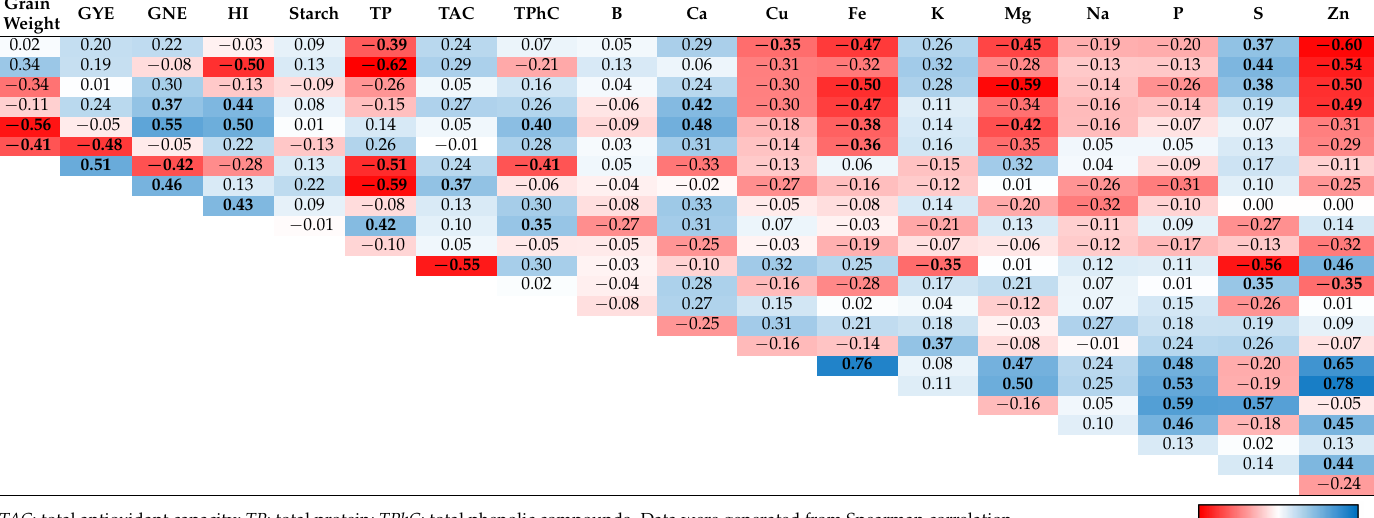
Table 6. Correlation coefficient matrix for the wheat production, grain yield, non-mineral, and mineral nutrient components among of 10 wheat genotypes grown under elevated CO 2 and high temperature. Stalk Chaff Grain Yield Grain Number